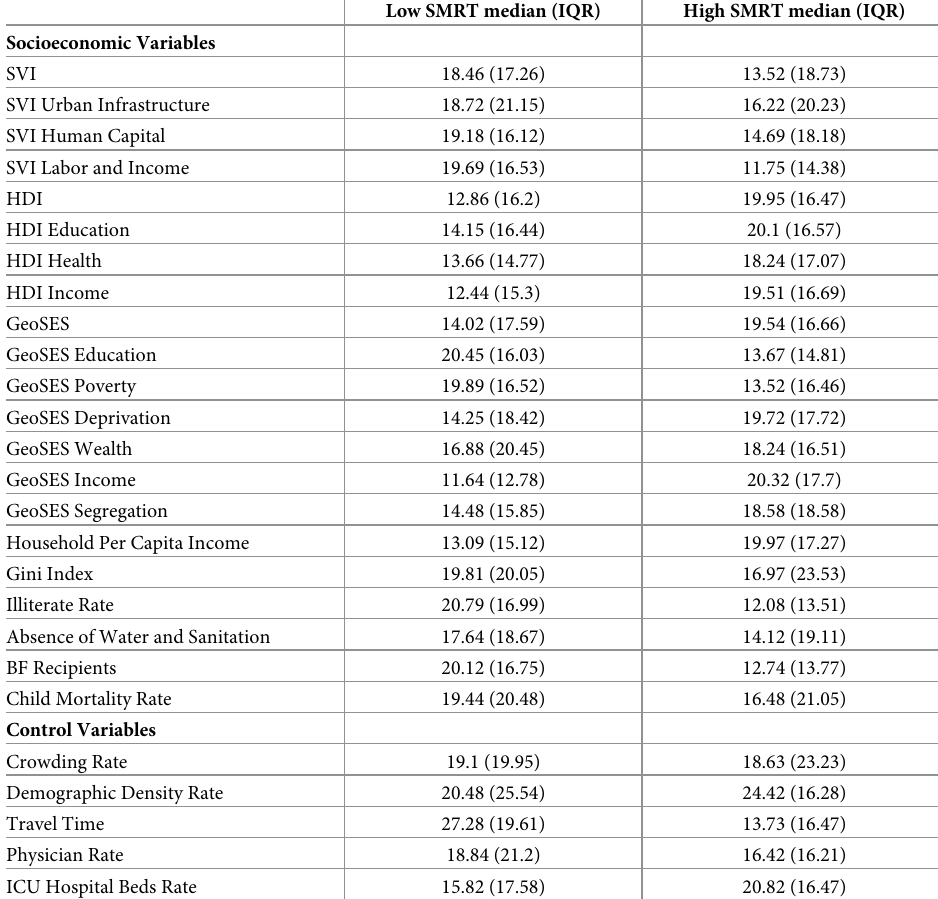
Table 1. Descriptive analysis of Brazilian municipalities by low (1 st decile) and high (10 th decile) SMRT, and socio- economic attributes. Brazil,